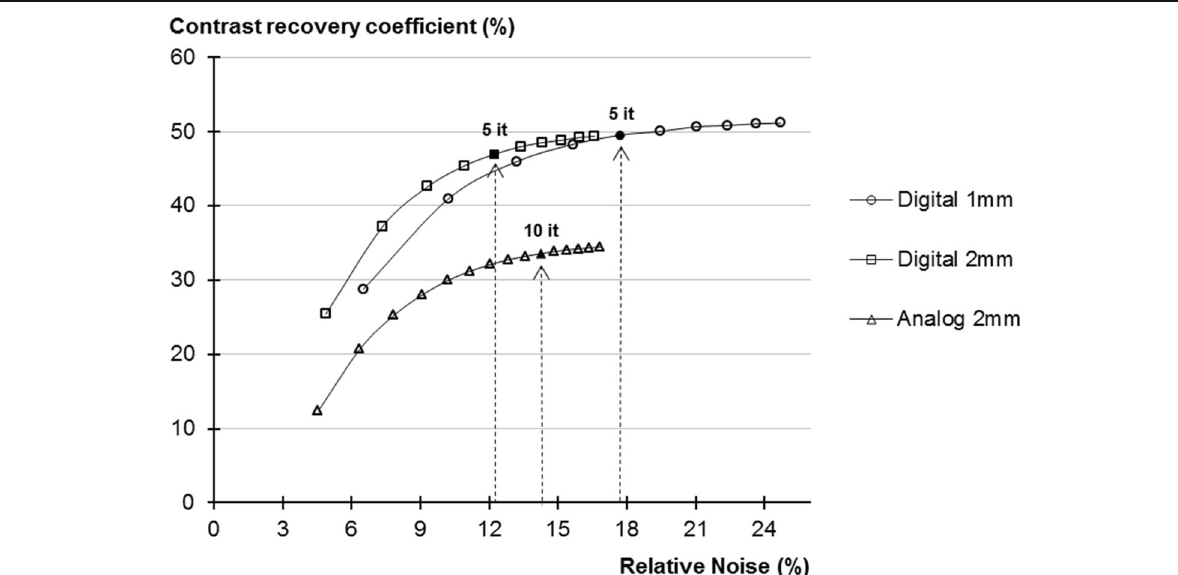
Fig. 1 Contrast recovery coefficients determined in percentages for the 10-mm hot sphere, with 2-mm voxel size for analog and digital PET and with 1-mm voxel size for digital PET and displayed according to relative noise (coefficient of variation in the background, in percentages) for each number of iterations. Black symbols and dashed arrows represent the numbers of iterations considered to reach sufficiently high levels of convergence. This convergence was reached at 5 iterations for the digital PET with either 1-mm or 2-mm voxels size and at 10 iterations for the analog